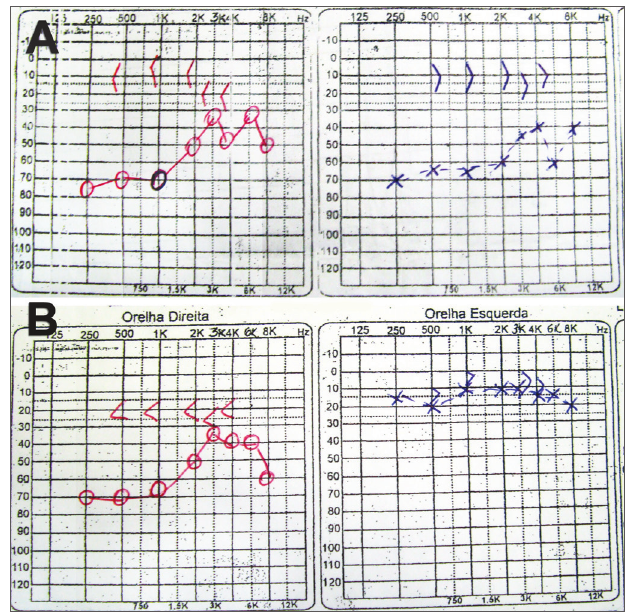
Figura 5. Fac-símile de exame audiométrico de paciente submetida à estapedotomia exclusivamente endoscópica em ouvido esquerdo. A: exame pré-operatório mostrando perda auditiva do tipo condutiva bilateralmente. B: exame pós-operatório evidenciando perda auditiva condutiva em ouvido direito e dentro dos limiares normais em ouvido esquerdo.